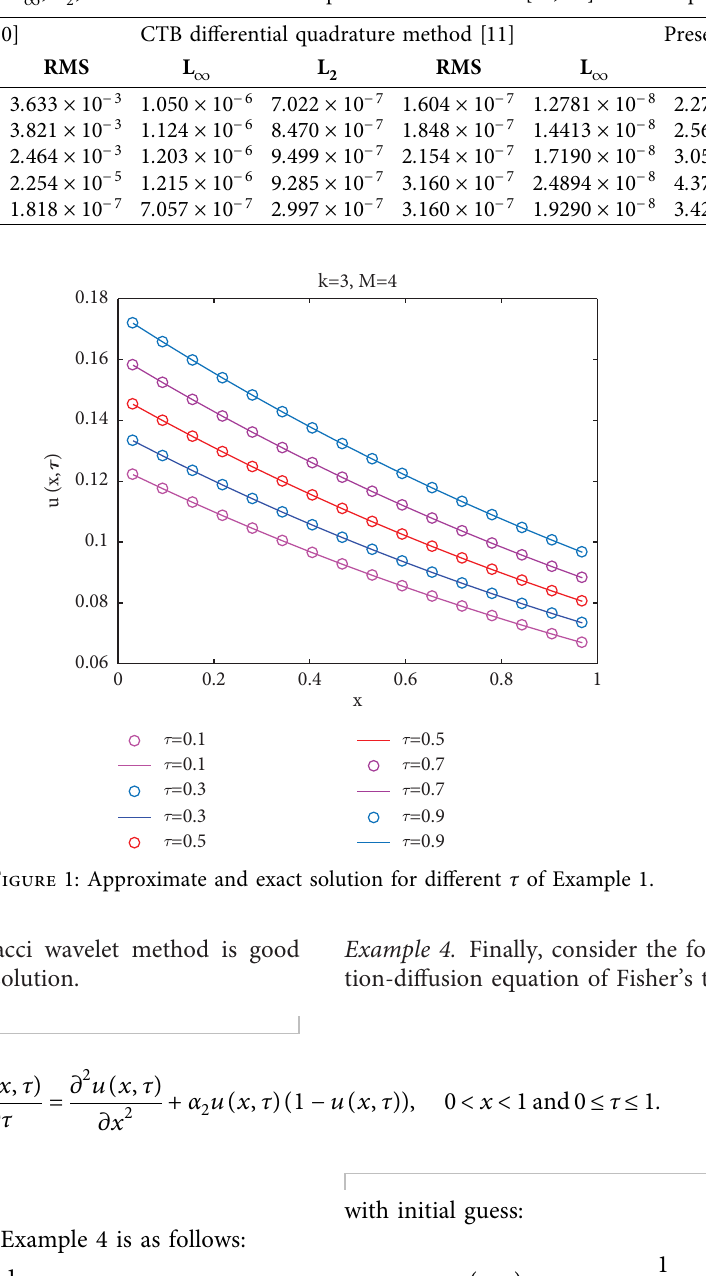
Table 1: Comparison of L